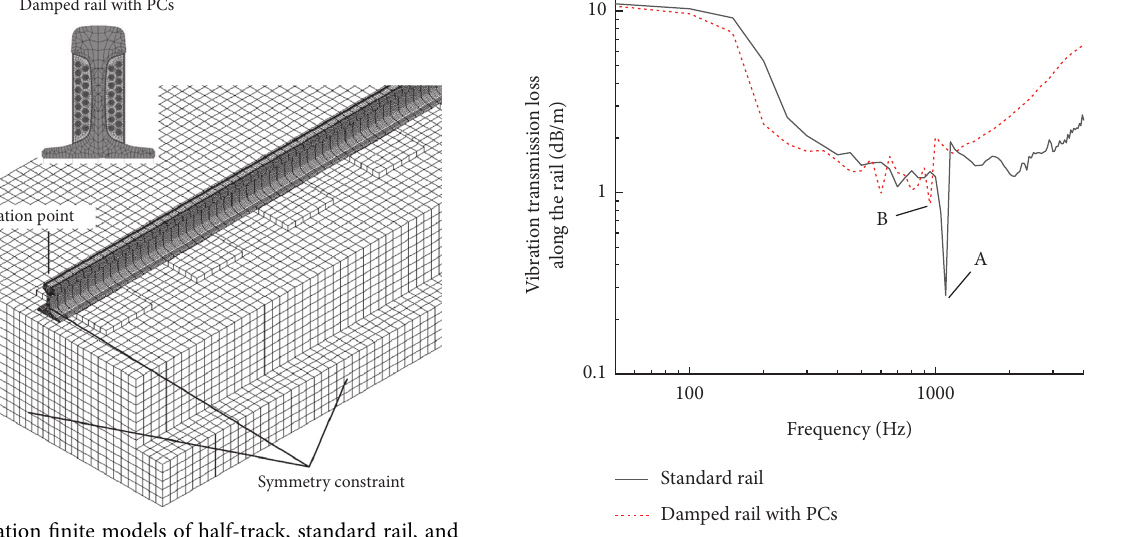
Figure 9: Vibration transmission losses of standard rail and damped rail with PCs.